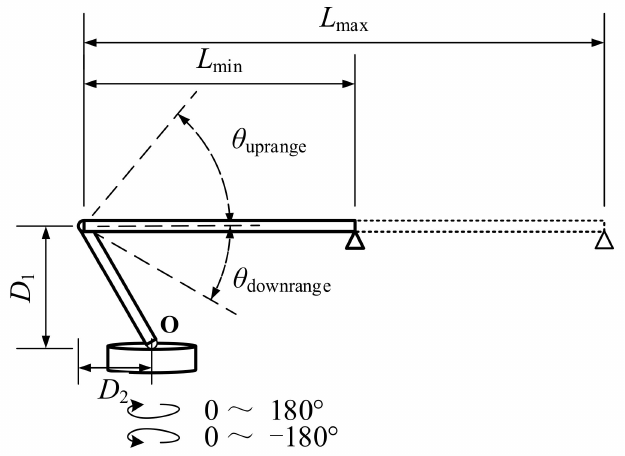
Figure 1. Structure of the